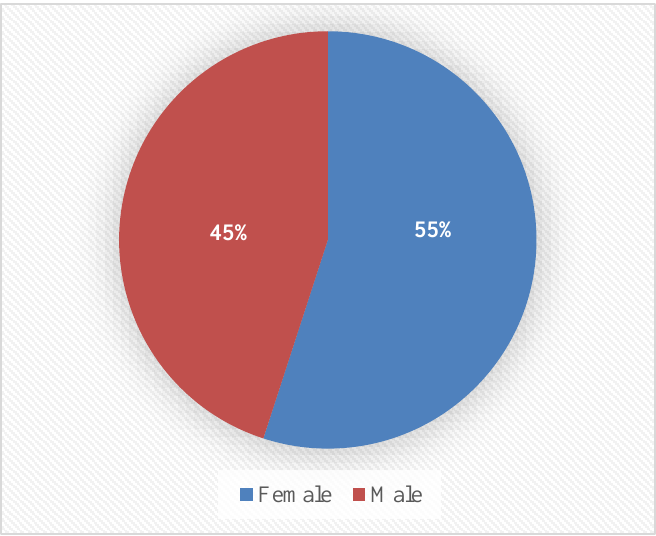
Figure 3. Statistical results for